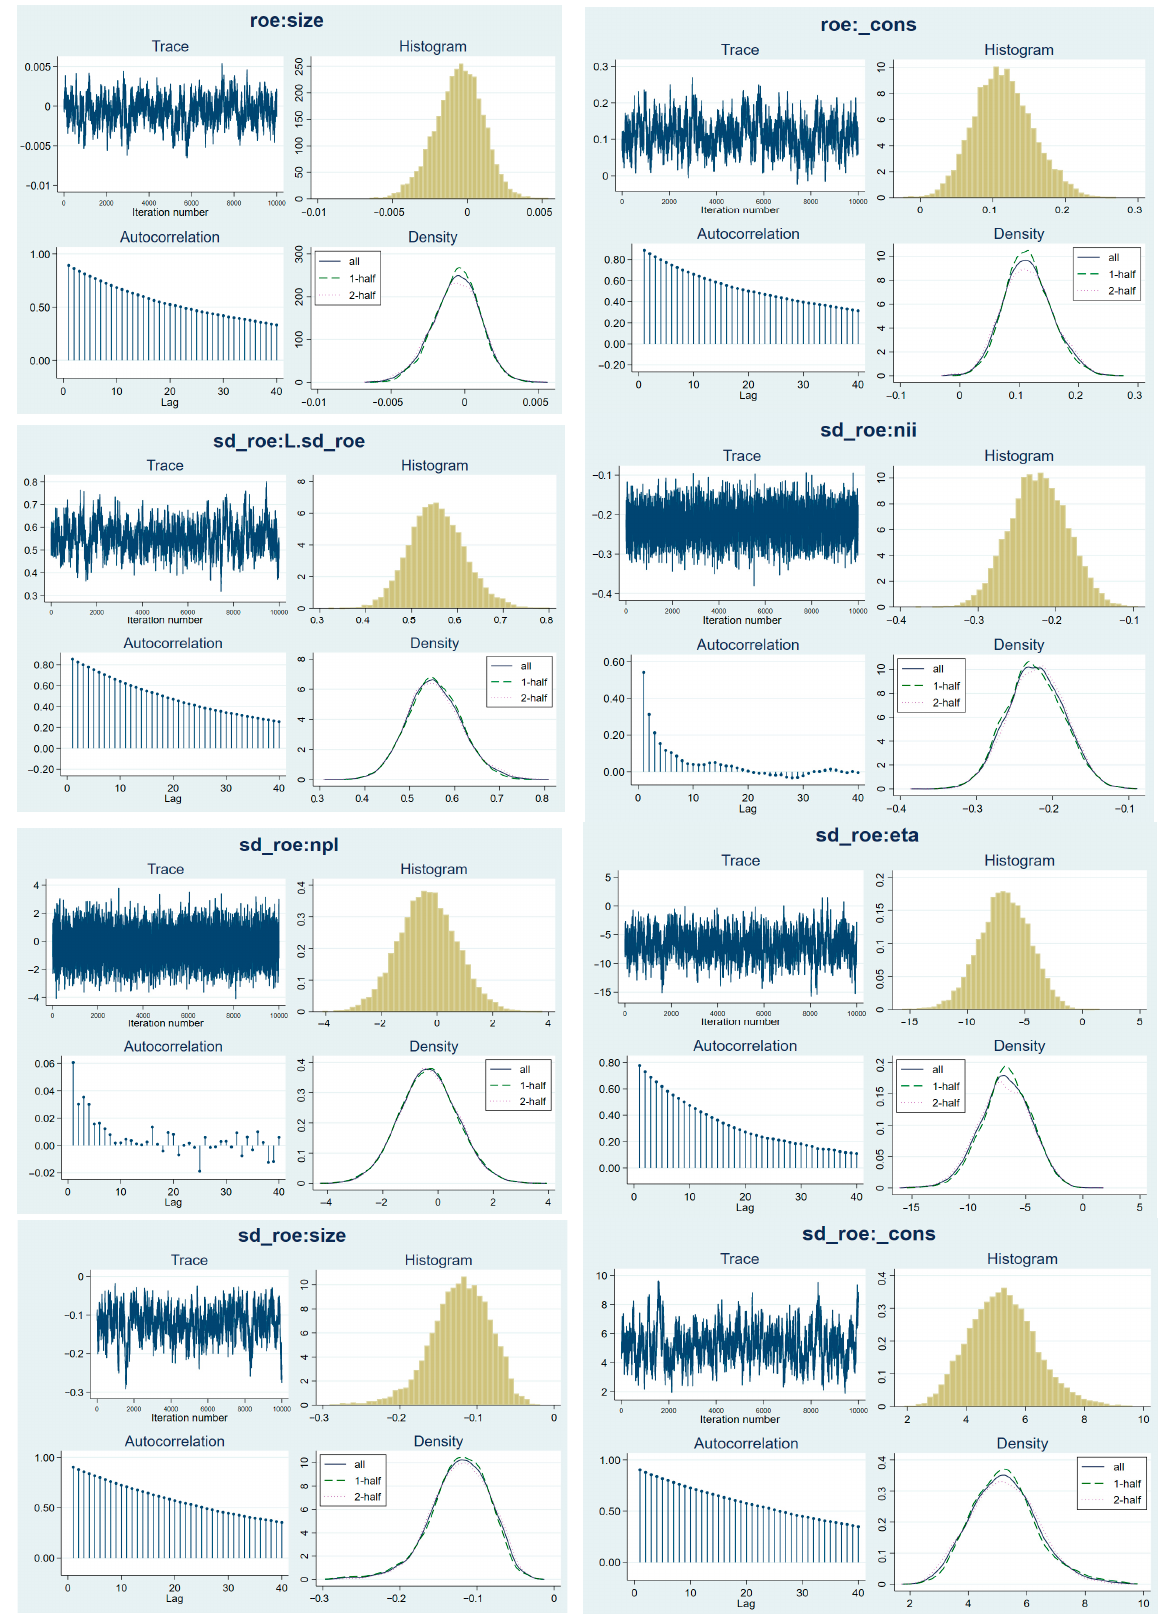
Figure 1. Results of testing the convergence of MCMCs in the model with ROE, SD_ROE as dependent variables.